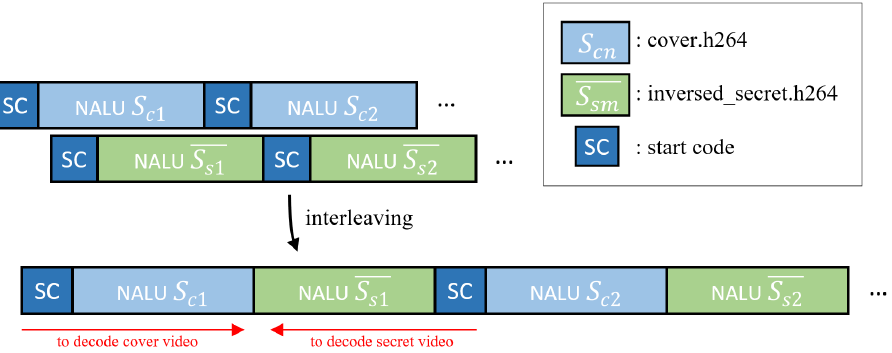
Figure 3. Examples of properties of interleaved NALU used in the reception method. When interleaved with one stream, an emulation prevention process should be con- ducted. The secret stream space can be placed in an encrypted stream or characters, video, etc., but bytes such as start code can appear in the stream. If there is a start code in the secret video, the decoder emulates the next NALU decoding stage, meaning that an emulation prevention process must be removed. When the video encoder completes the picture in the entropy coding stage, a stream called the string of data bits (SODB) is completed, as shown in Figure 4. Each encoded symbol in the SODB is coded with a variable length with a symbol frequency; therefore, a step for aligning in byte units suitable for transmission is required. The stream for which the byte alignment is completed in the SODB is called the raw byte sequence payload (RBSP). This RBSP may occasionally contain a specific string of bytes that can be emulated. In the case of H.264, 0 × 000000, 0 × 000001, 0 × 000002, and 0 × 000003 are registered as emulation bytes. Adding emulation_prevention_three_byte 0 × 03 between the second and third bytes to prevent emulation of bytes that appear acci- dentally is called emulation prevention processing. After emulation prevention processing in RBSP, it is called an encapsulated byte sequence payload (EBSP), which can be stored directly in NALU. In the case of the cover NALU through the encoder, there is no need for additional emulation prevention processing because all processes are implemented in the encoder. However, the streams that processed invertible functions in the B . stage are necessary to perform the emulation prevention process again. Then, the final stream is com- pleted by performing emulation prevention processing on the reversed stream according to the features of each